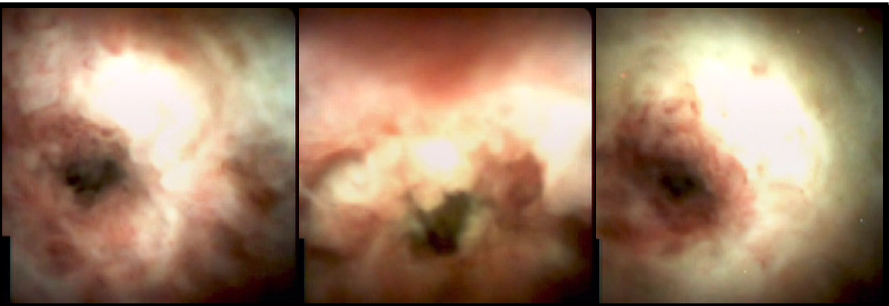
Figure 2. Cholangioscopy images of a stenosis just below the hepatic hilum, obtained with the SpyGlass DS system. Cholangioscopy-targeted biopsies confirmed the presence of adenocarcinoma (type I cholangiocarcinoma according to Bismuth–Corlette classification).